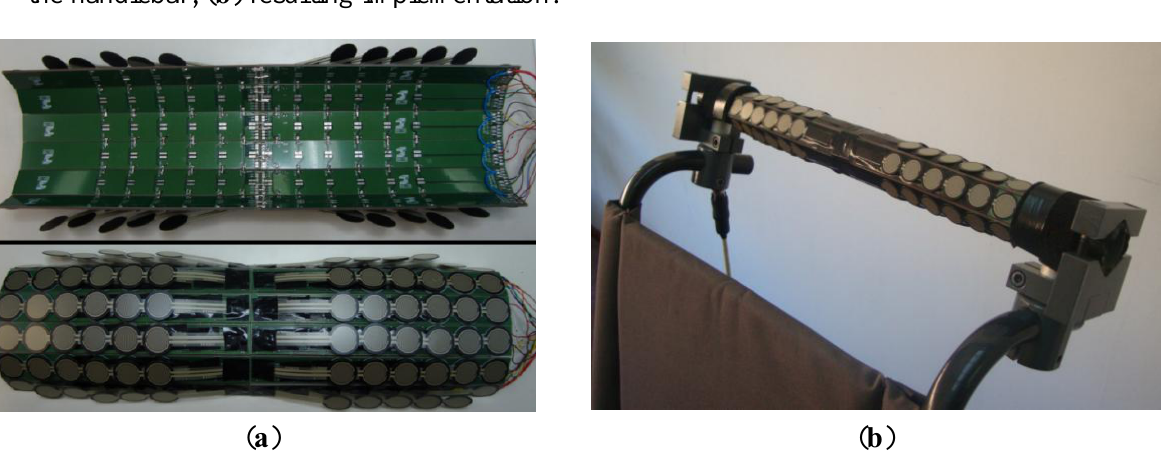
Figure 3. First prototype of the proposed device. ( a ) Raw tactile sensor prior to embracing the handlebar; ( b ) resulting